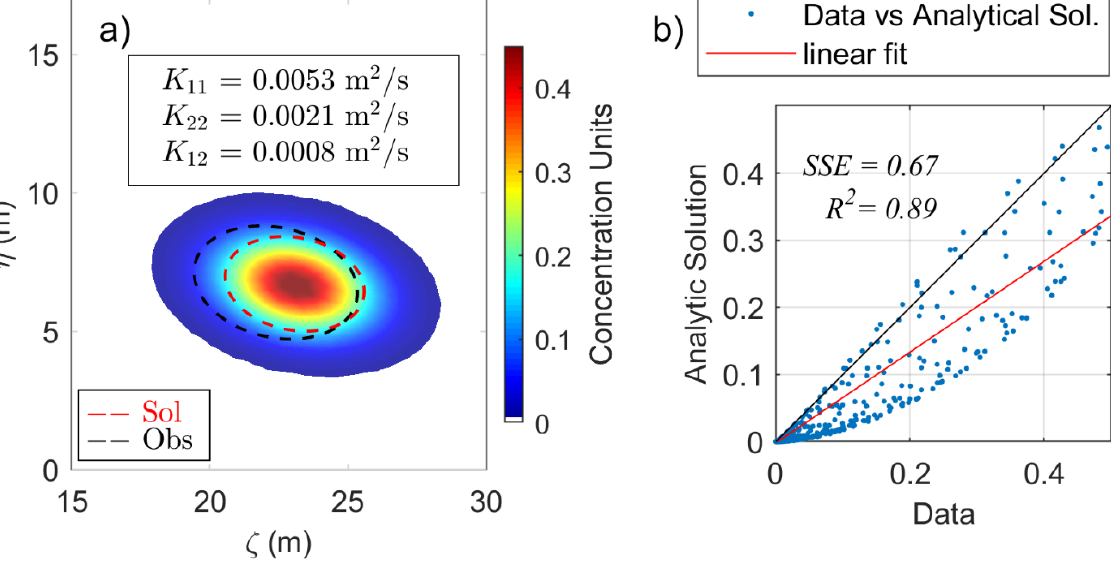
Figure 10. ( a ) Concentration contours obtained with optimal diffusion coefficients for 𝐾 11 ≠ 𝐾 22 and 𝐾 12 = 𝐾 21 ≠ 0 . Observations are shown in black and the solution in red. In ( b ), the dispersion diagram of the data and the analytical solution with SSE and 𝑅 2 is shown.